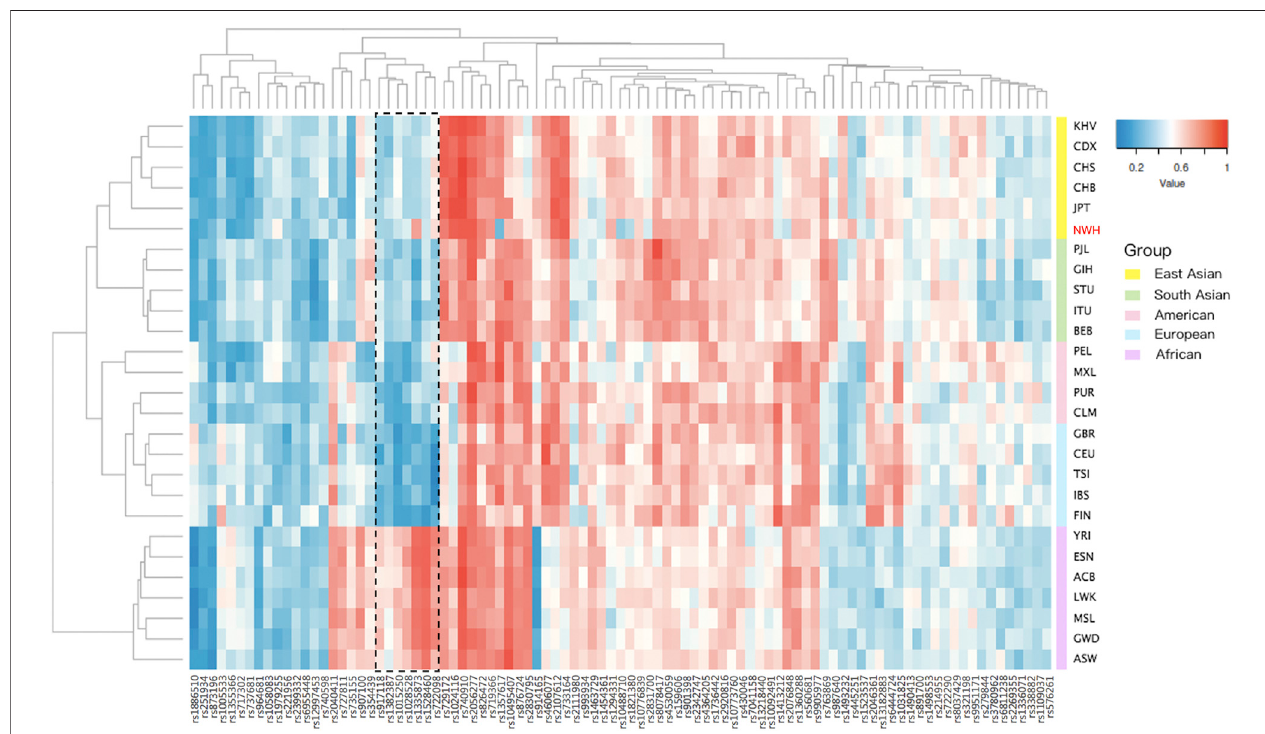
FIGURE 2 | Cluster heatmap constructed based on allele frequencies of 93 overlapping IISNP loci in the Northwest Hui and 26 reference populations. IISNP, identity-informative single nucleotide polymorphism.